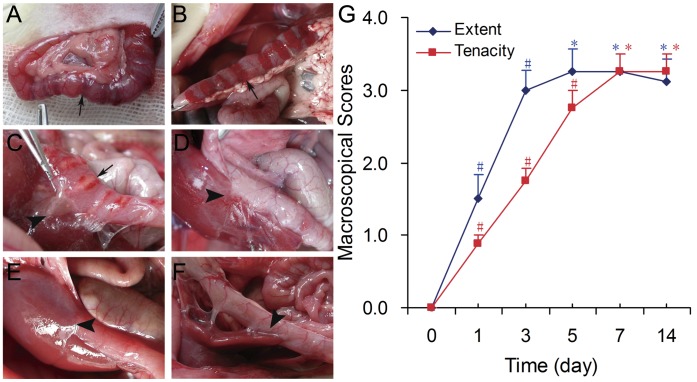
Representative macroscopical photos and adhesion scores.A–F) Macroscopical photos of 0 day, 1st, 3rd, 5th, 7th and 14th day. G) Mean of adhesion scores by macroscopical evaluations in all groups. n = 8, #: P<0.05, *: P>0.05. Vs. preceding group. (Surgical site: arrow; adhesion: arrowhead).